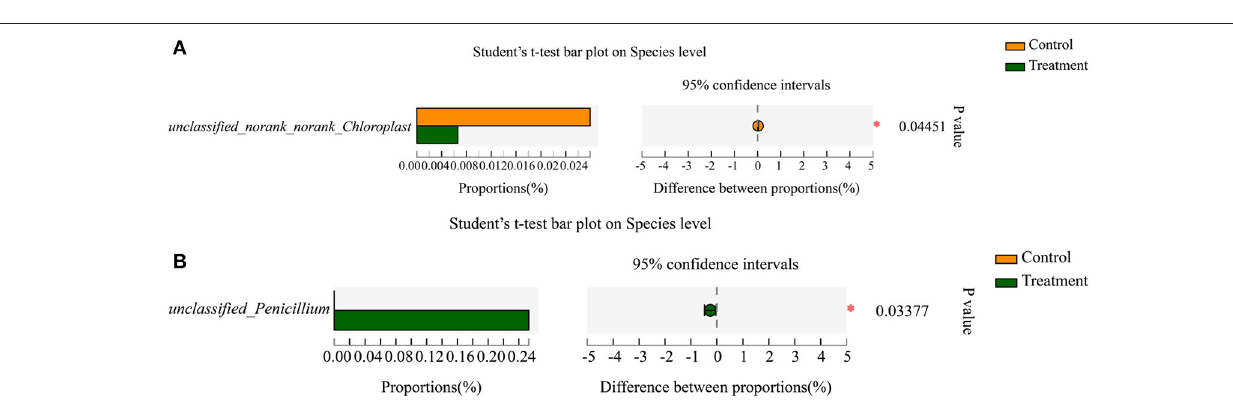
“R1” ( Supplementary Figure 6F ). In Supplementary Figure 7C